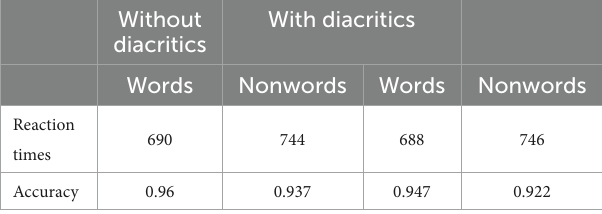
TABLE 1 Mean reaction times (in ms) and accuracy in all